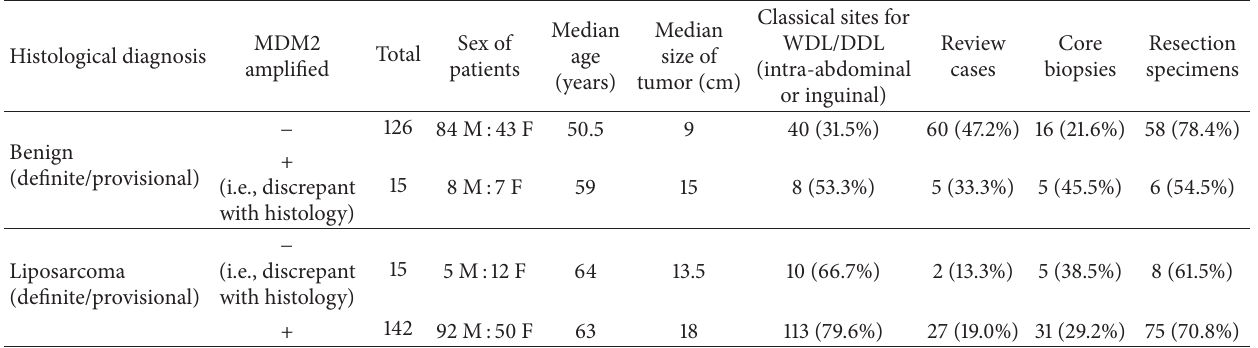
Table 3: Comparison of patient and tumor characteristics in cases with concordance or discrepancies of histology and FISH.